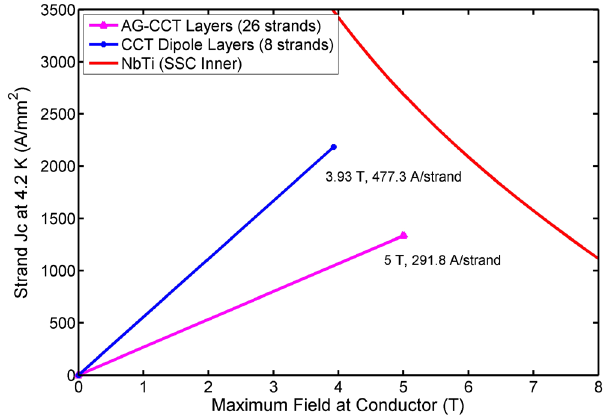
FIG. 10. The short sample in the superconductor using SSC inner NbTi strand is shown for both the AG-CCTand CCT dipole layers of the 75 degree bend (B1,B2). Both sets of layers have a current margin of more than 25% for the given number of